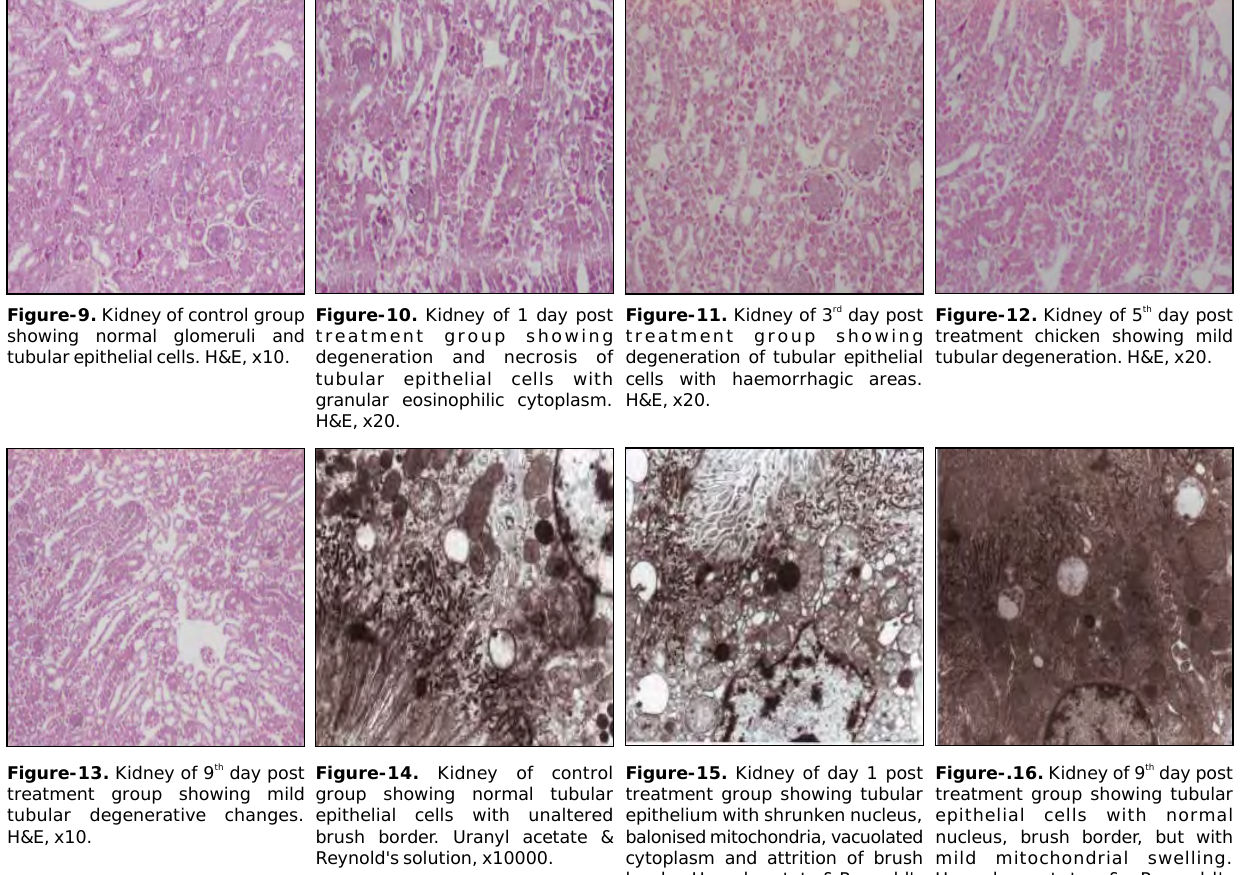
Figure-15. Kidney of day 1 post treatment group showing tubular epithelium with shrunken nucleus, balonised mitochondria, vacuolated cytoplasm and attrition of brush border. Uranyl acetate & Reynold's solution, x10000.